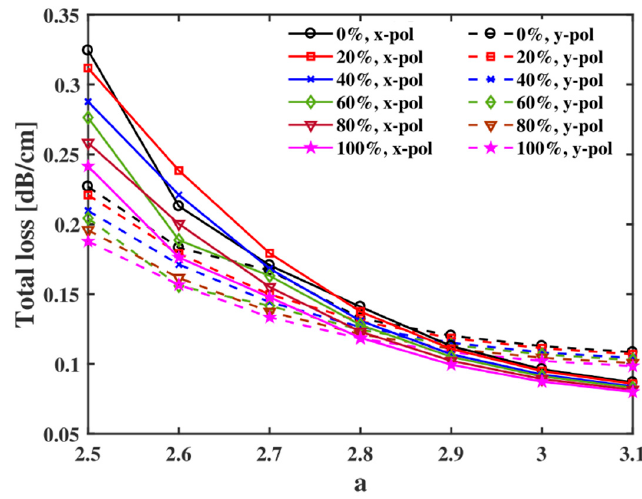
Figure 14. Total loss as a function of a of the reported oil adulterated sensor at 2.8 THz.